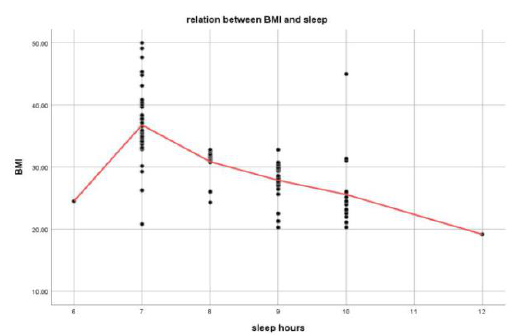
Fig. 3. The significant inverse association between BMI and hours of sleep according to the probability value in the correlation test (p=0.000) in table (2).